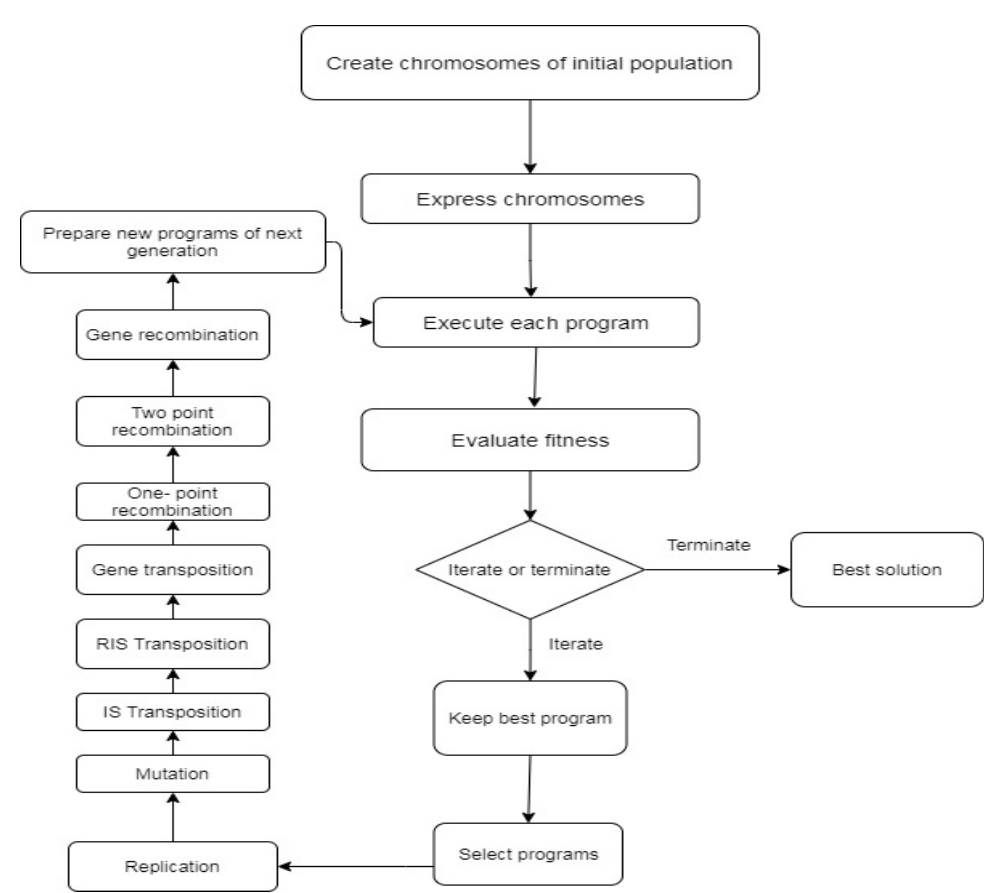
Figure 7. The flow-chart of Gene Expression Programming.